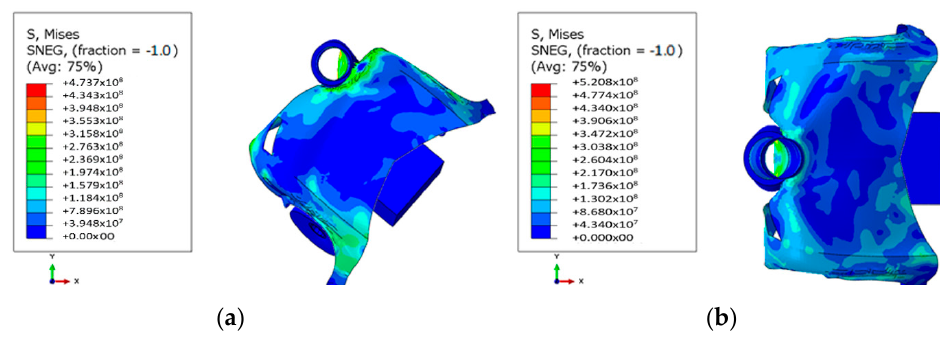
Figure 4. Top view of the Mises stresses of the collision with ( a ) corner collision and ( b ) frontal collision.